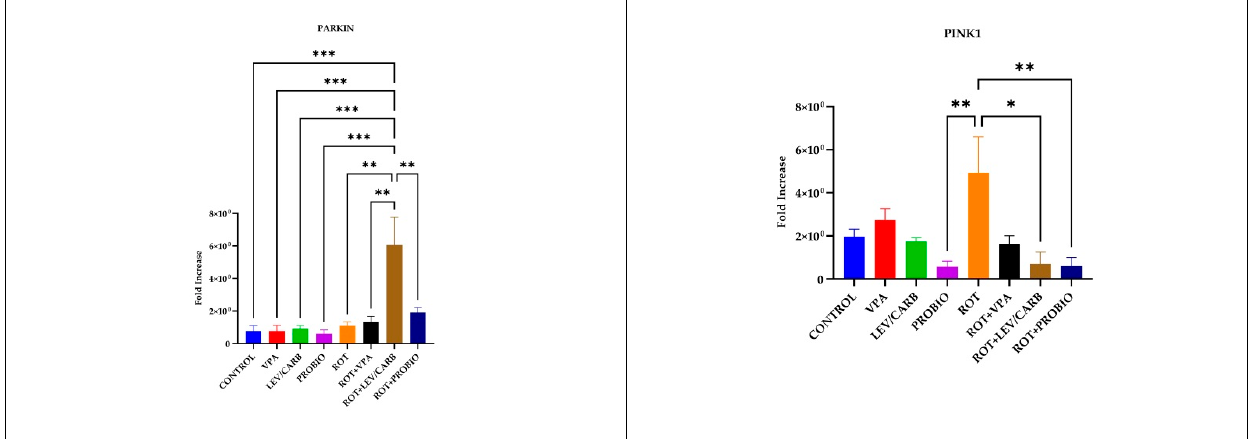
Figure 7. LRRK2 , SNCA , PARKIN, and PINK1 relative expression levels in the brain of studied Danio